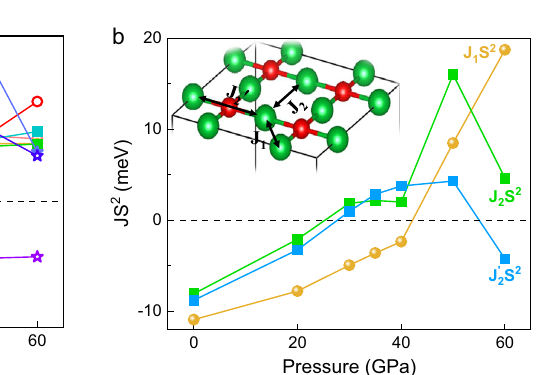
interaction of Fe-Fe contribution ( J 1 ), the next-nearest-neighbor interaction of Fe- Se-Fe contribution ( J 2 ), and the next-nearest-neighbor interaction of Fe-O-Fe con- tribution ( J 2 ′